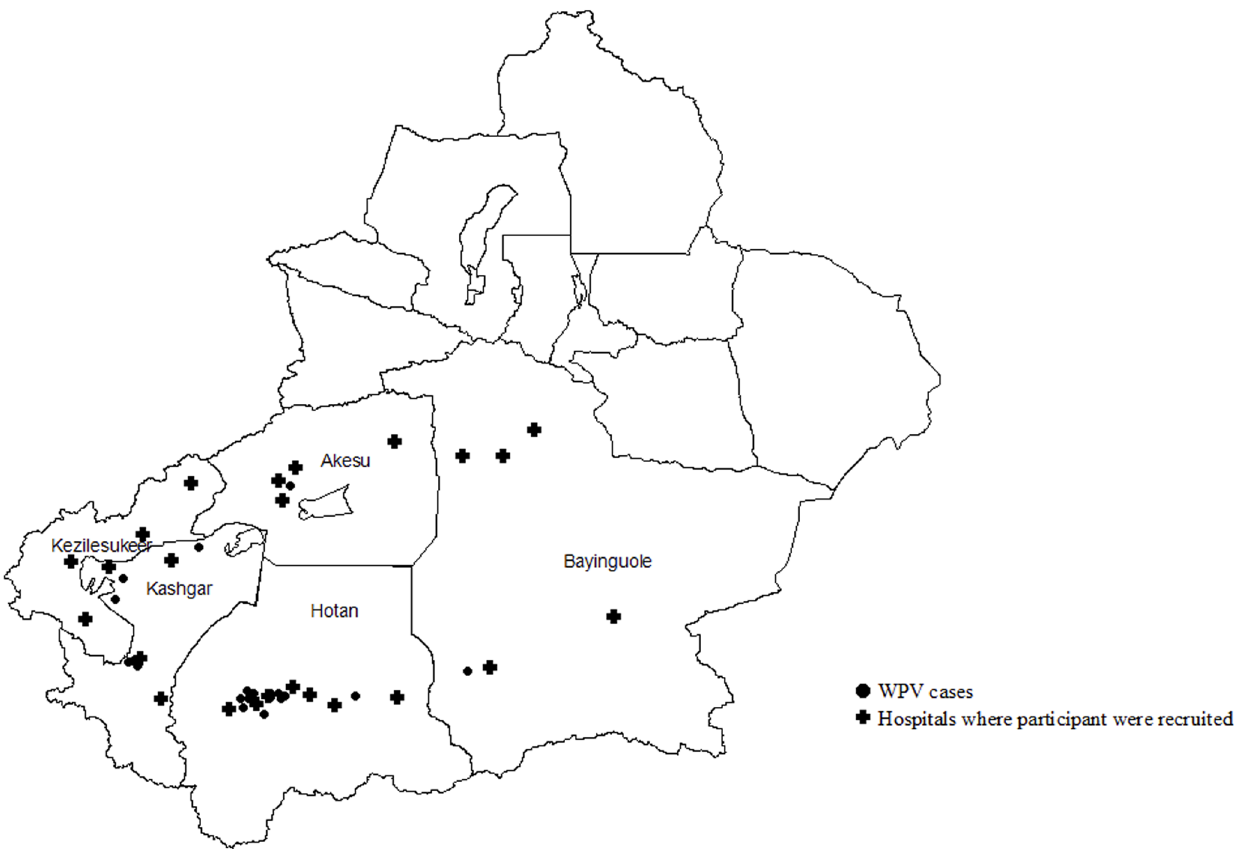
Figure 1. Distribution of WPV cases and hospitals in which blood specimens were collected in southern Xinjiang Uygur Autonomous